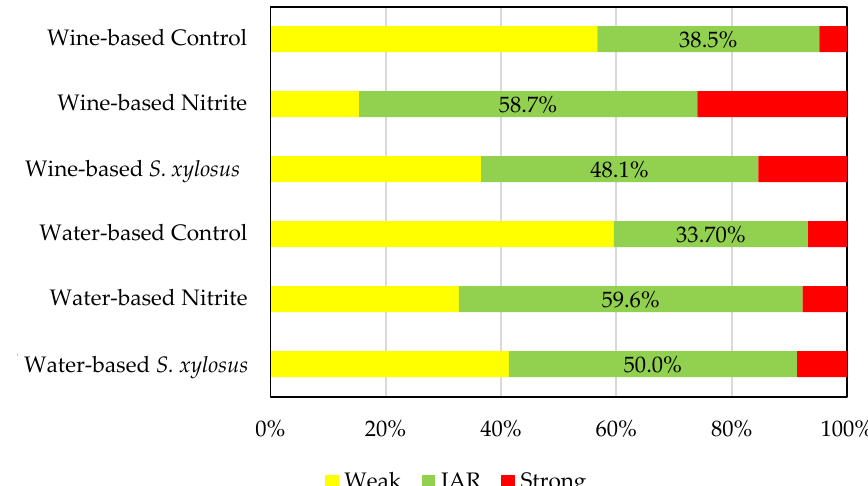
Figure 2. Just About Right evaluation of cured loins.